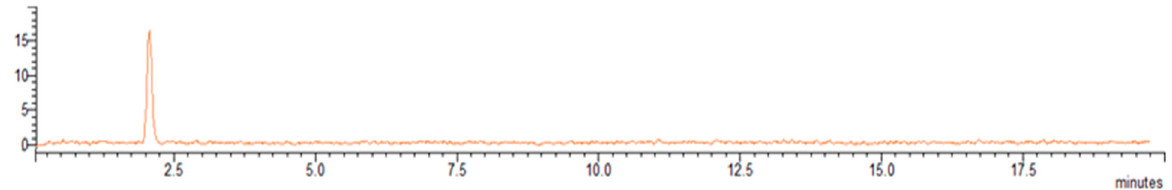
Figure 2. Chromatogram of BIT in the standard solution. Table 1. The inter-day recovery rate and precision of BIT analysis.